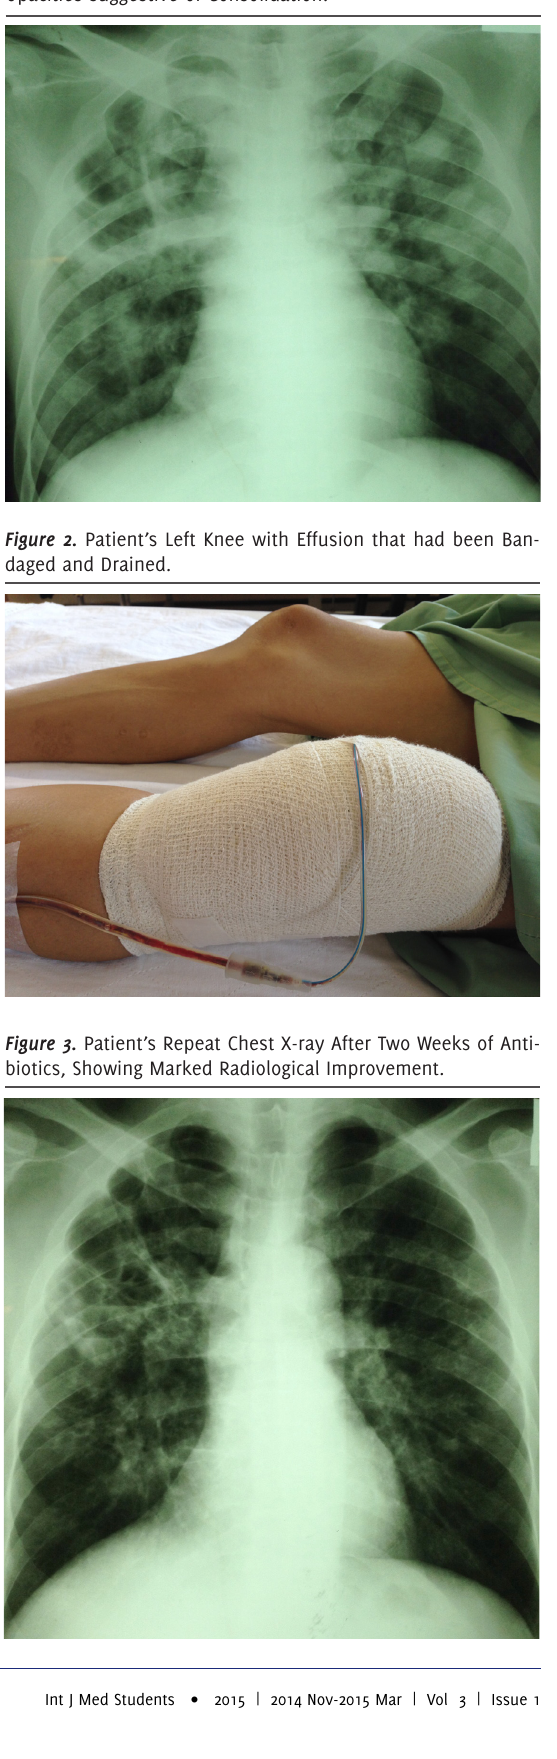
Figure 1. Patient’s Chest X-ray, Showing Bilateral Diffuse Patchy Opacities Suggestive of Consolidation.